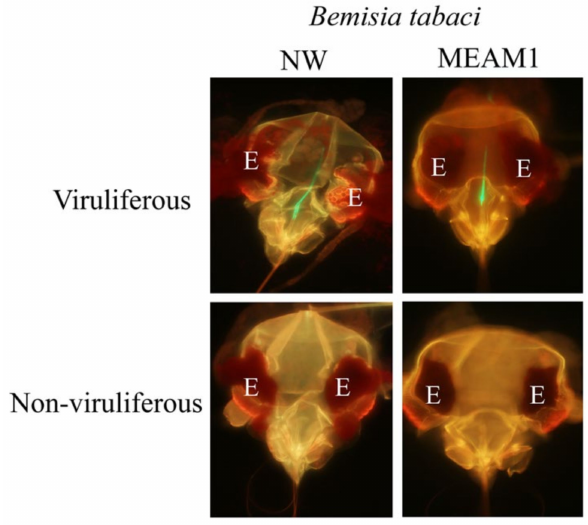
Figure 1. Foregut retention of in planta acquired LCV (GH-LCV) in two B. tabaci vector species. Representative images of the dissected heads of viruliferous (top panels) and non-viruliferous (bottom panels) vectors that were given acquisition access feeding on infected and uninfected source plants, respectively. Vectors were subjected to immunofluorescent localization (virus retention assay) and examined by wide-field fluorescence microscopy. E, eye; NW, B. tabaci New World vector; MEAM1, B. tabaci Middle East–Asia Minor 1